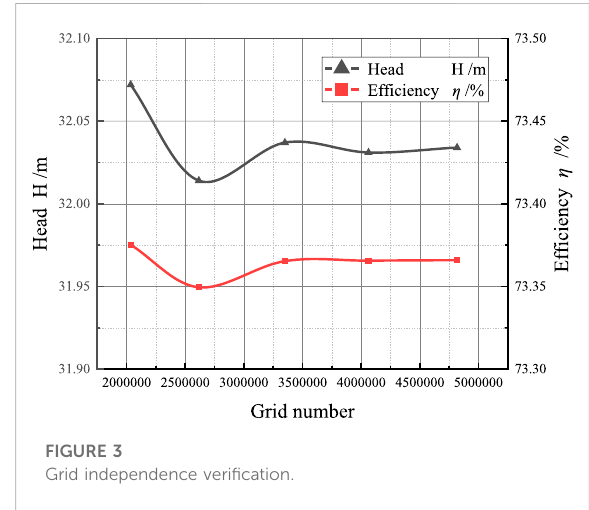
FIGURE 3 Grid independence veri fi